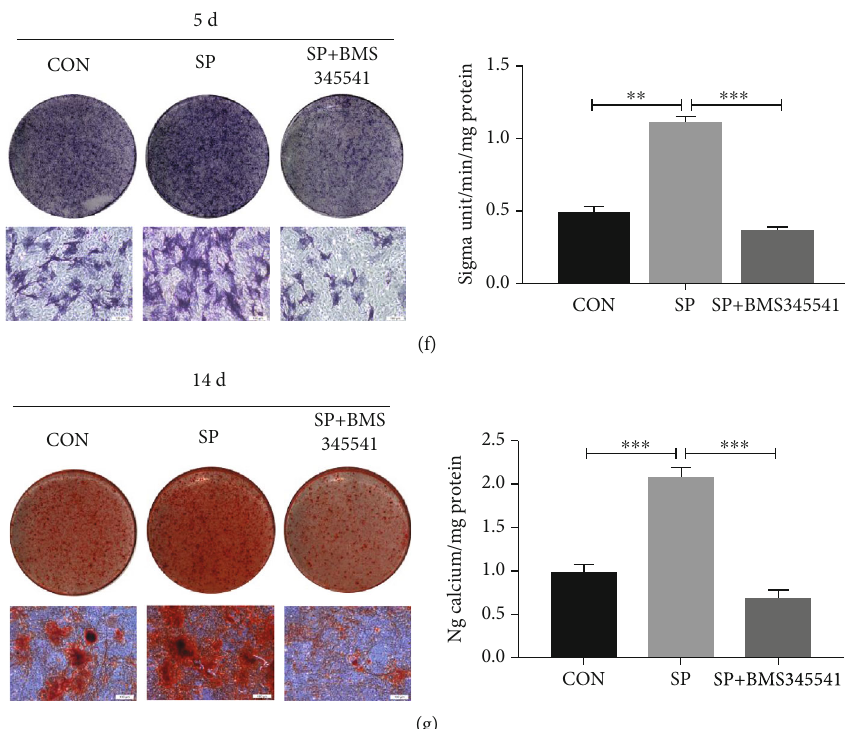
Figure 3: Impact of iRoot SP on the NF- κ B cascade of BMSCs. (a) Protein expression of I κ B α , p-I κ B α , P65, and p-P65 in the cytoplasm and nuclear P65 of SP-treated BMSCs at di ff erent time points. GAPDH was used as the internal control. Gray scale evaluations of protein by ImageJ. ∗ p < : 05 , ∗∗ p < : 01 , ∗∗∗ p < : 001 . (b) Immuno fl uorescence assay of nuclear P65 at di ff erent time points. Scale bar = 50 μ m . (c) Protein titers of cytoplasm P65, p-P65, I κ B α , and p-I κ B α , as well as nuclear P65, in the NC group, SP group, and SP + BMS345541 group at 30 min. GAPDH and Histone 3 were used as internal controls. Gray scale assessment of protein bands by ImageJ. ∗∗ p < : 01 , and ∗∗∗ p < : 001 . (d) Gene expression of Dspp, Opn, Runx2, and Osx in the NC group, SP group, and SP + BMS345541 group at 30min. ∗∗ p < : 01 , ∗∗∗ p < : 001 . (e) Protein expression of DSPP, OPN, RUNX2, and OSX in di ff erent groups at day 7. ∗ p < : 05 , ∗∗ p < : 01 , ∗∗∗ p < : 001 . (f) ALP staining and ALP enzyme activity in the BMS345541+ SP group and SP group after 5 days. Scale bar = 100 μ m . ∗∗ p < : 01 , and ∗∗∗ p < : 001 . (g) Figures of Alizarin Red S staining of BMSCs in di ff erent groups. Absorbance was measured to evaluate the degree of mineralization. Scale bar = 100 μ m . ∗∗ p < : 01 , and ∗∗∗ p < : 001